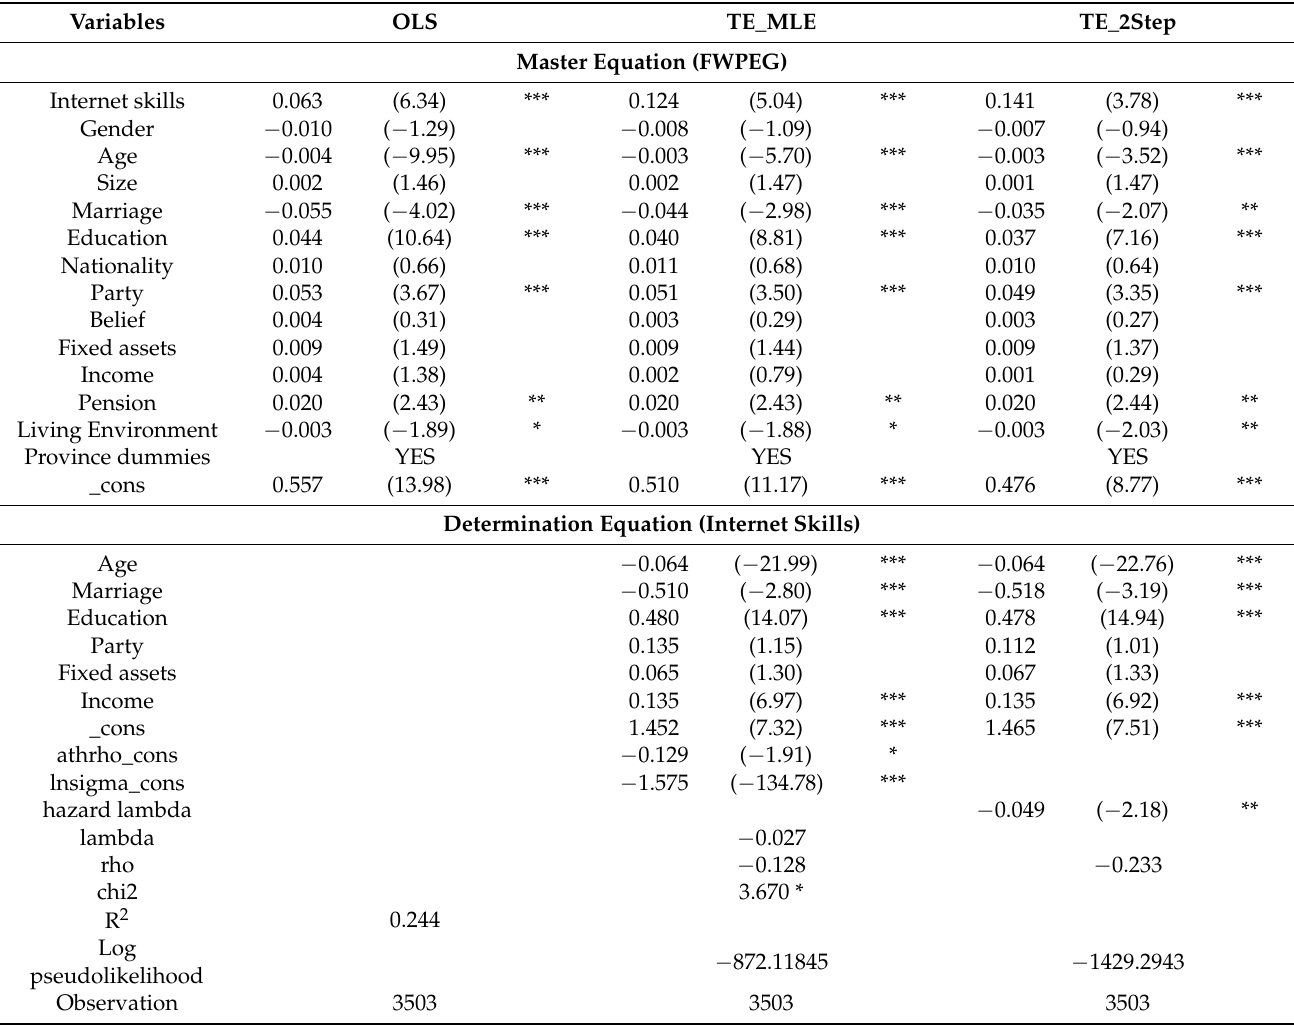
Table 5. Comparison of TE and OLS estimation